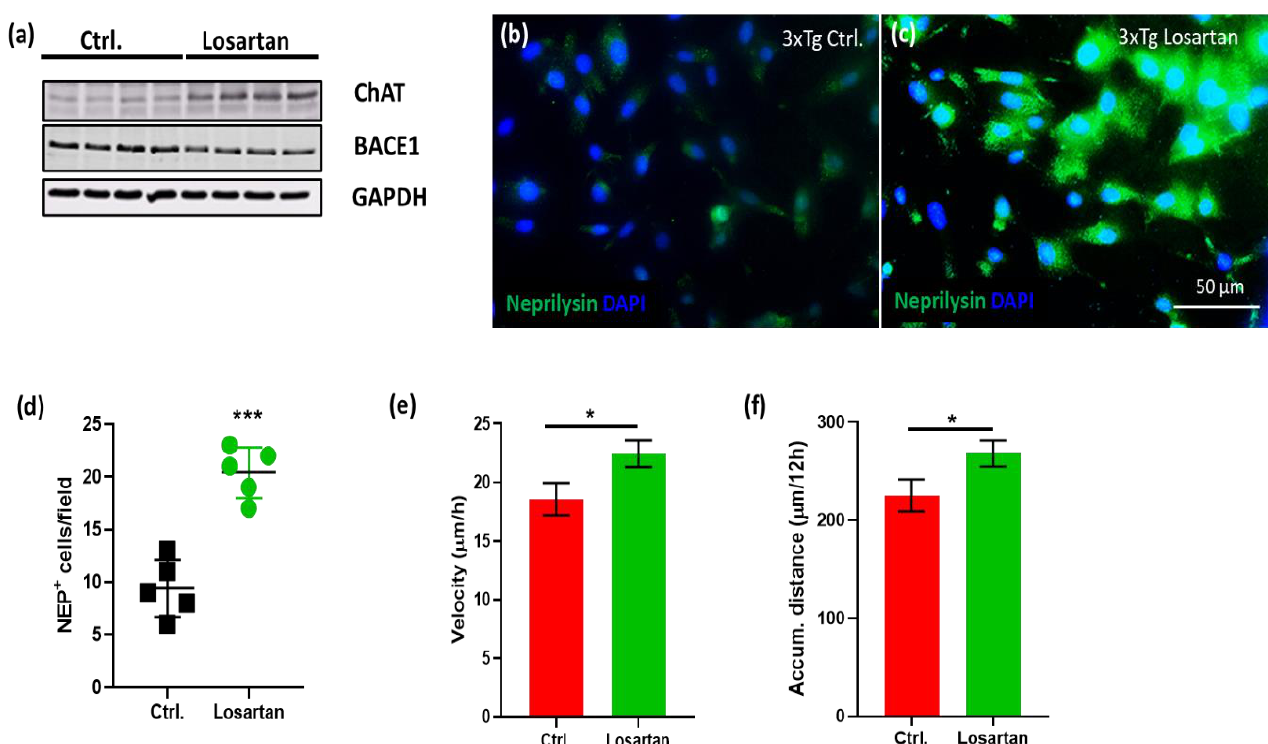
Figure 7. In vitro effects of losartan on triple transgenic Alzheimer’s disease (AD) mice (3xTg-AD) APC. ( a , b ) Western Blot of ChAT and BACE1 in losartan vs. vehicle (Ctrl.) treated 3xTg-APC. ( b , c ) Expression of neprilysin (green) in losartan (3xTg losartan) and vehicle (3xTg Ctrl.) treated 3xTg-APC. Cell nuclei are stained with DAPI (blue), scale bar in ( d ) corresponds to the images shown in ( b , c ). ( d ) Quantification of neprilysin positive cells in 3xTg-APC ( n = 5). ( e ) Velocity of migrated cells in the control (ctrl.) and losartan treated 3xTg-APC. From the cells shown in videos in Supplementary Figure S1, we identified and analyzed 32 cells per treatment group ( n = 32) which were trackable for at least 12h; ( f ) accumulated distance calculated for cells described in ( e ); Statistical analysis in ( d – f ): t -test, * p < 0.05, *** p < 0.0005.